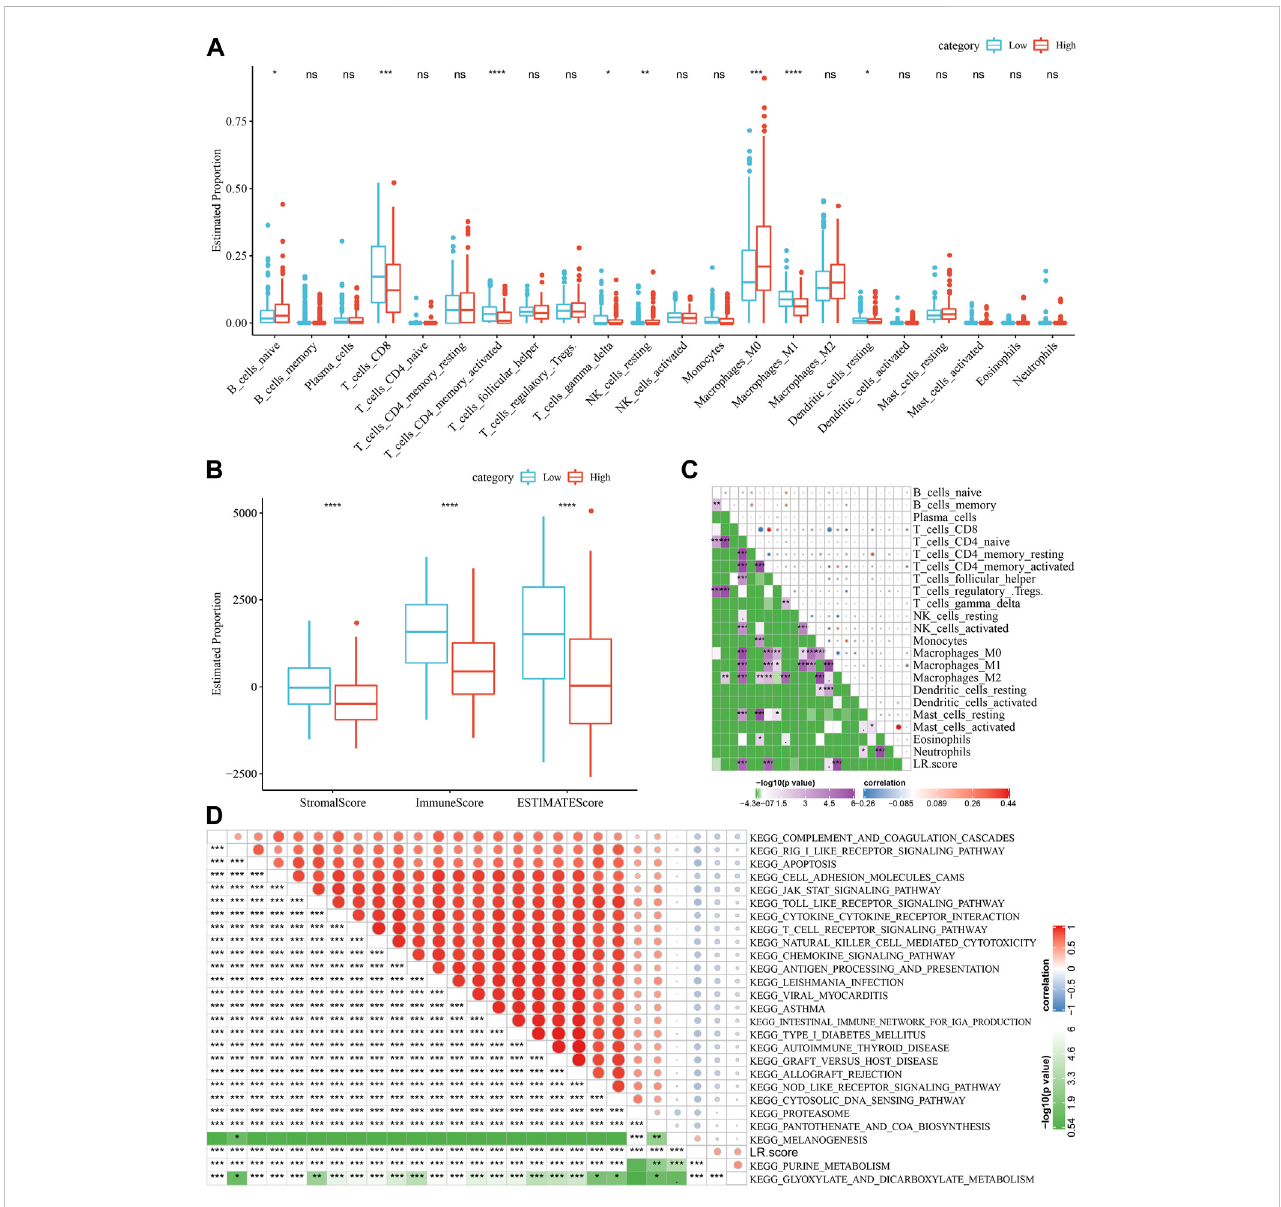
FIGURE 9 Correlation betweenLR.scoreand immunity and related pathways. (A) The proportion of immune cells in theTCGA-SKCM cohort. (B) The proportion of immunecellsintheTCGA-SKCMcohortcalculatedbyESTIMATEsoftware. (C) Thecorrelationbetween22immunecellsinTCGA-SKCMandtheLR.score. (D) KEGG pathway and LR.score in TCGA-SKCM whose correlation with LR.score is greater than